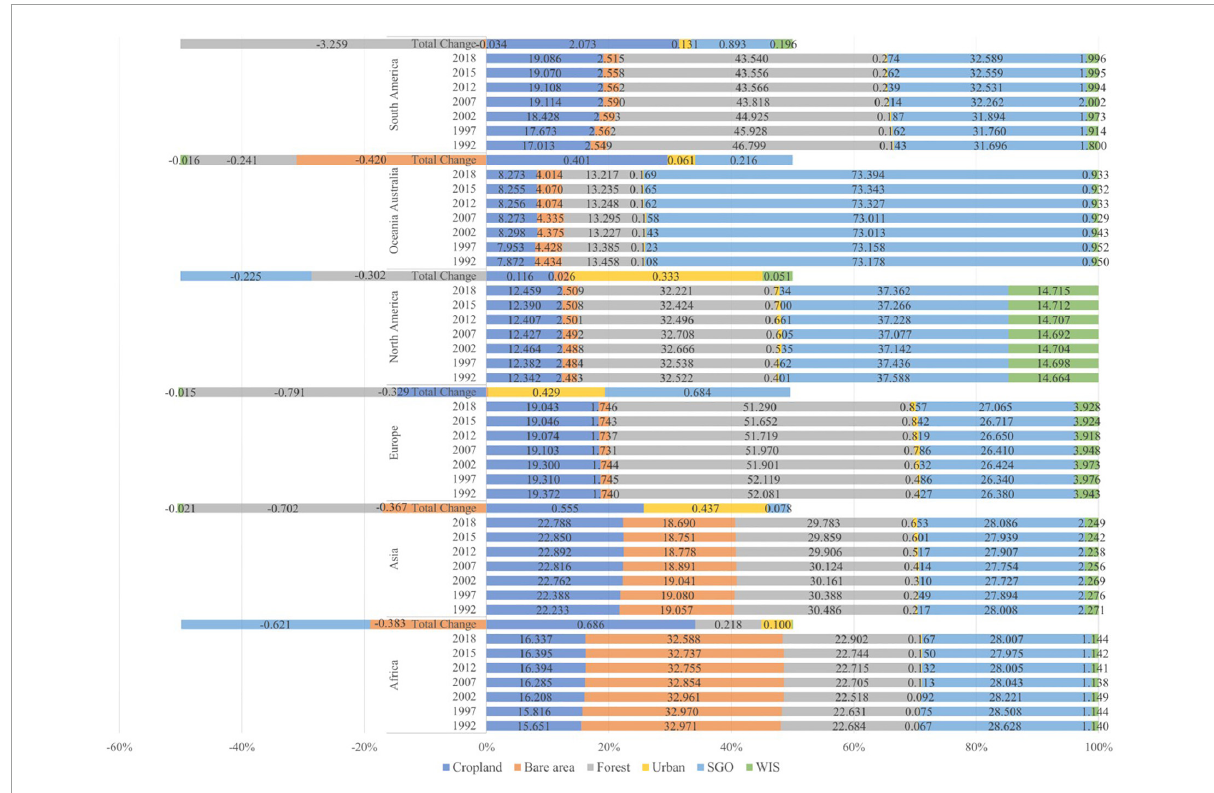
FIGURE6 The percentage land-cover changes for each year by